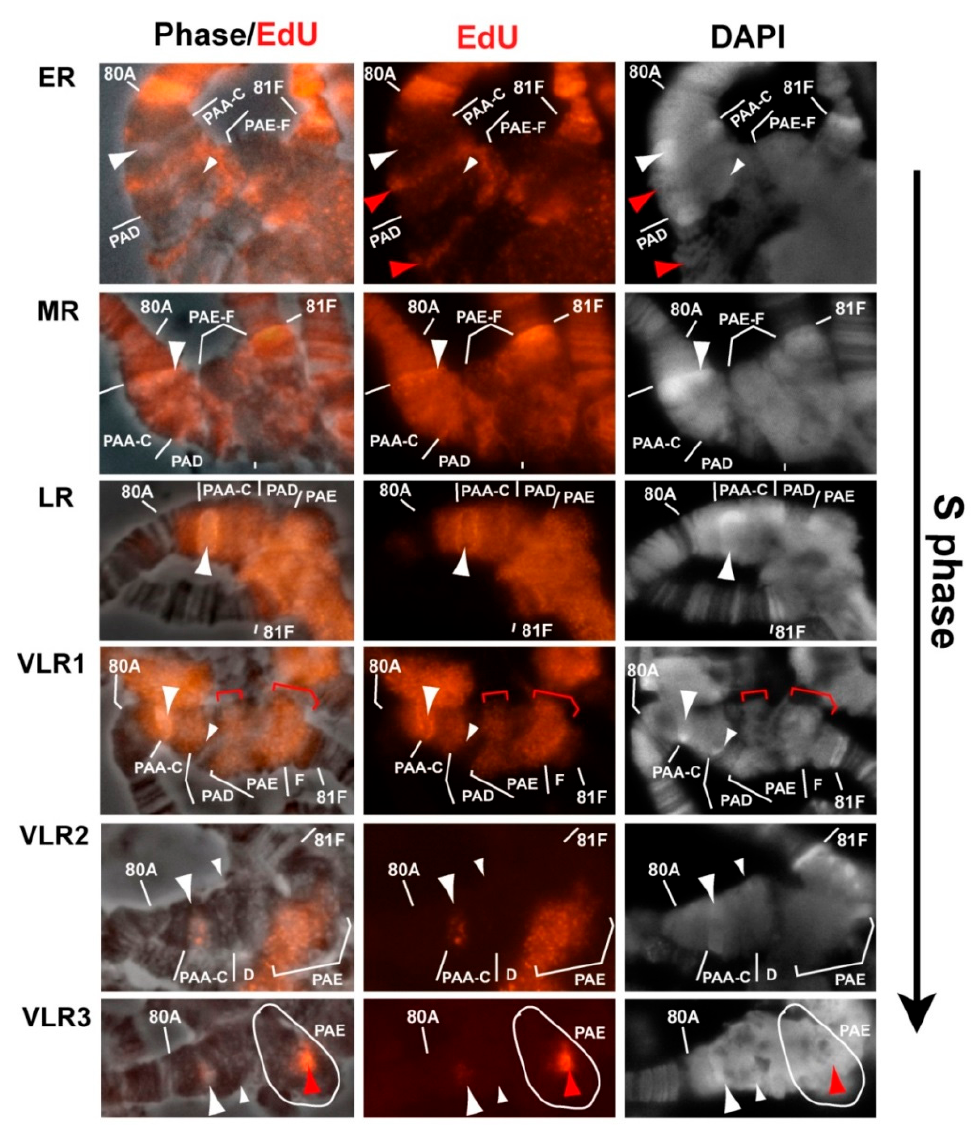
Figure 11. Sequential patterns of pulse EdU incorporation into the pericentromeric region of chromosome 3. The left panel is a superposition of the EdU signal on a phase contrast image, the middle panel depicts EdU data, and the right panel illustrates DAPI staining. The red arrowheads and brackets mark the positions of EdU signals. A white outline indicates the PAE area. The stages of replication are given in accordance with Figure 8, but the VLR stage is divided into three: VLR1–3. The exposure parameters are not identical among different stages and were selected for the most convenient mapping of pericentromeric signals.